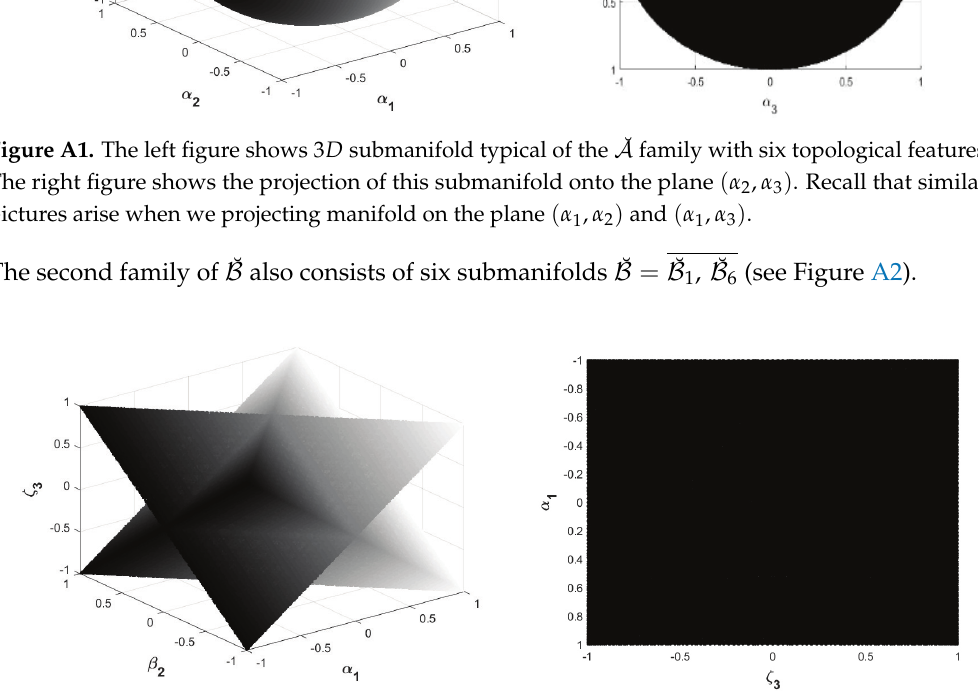
Figure A2. The left image shows a typical 3 D submanifold of the ˘ B family. As seen, a submanifold is smooth and has no topological features. The right figure shows the projection of this manifold on the plane ( α 1 , ζ 3 ) . Recall that similar pictures arise when we projecting manifold on the plane ( α 1 , β 2 ) and ( β 2 , ζ 3 )